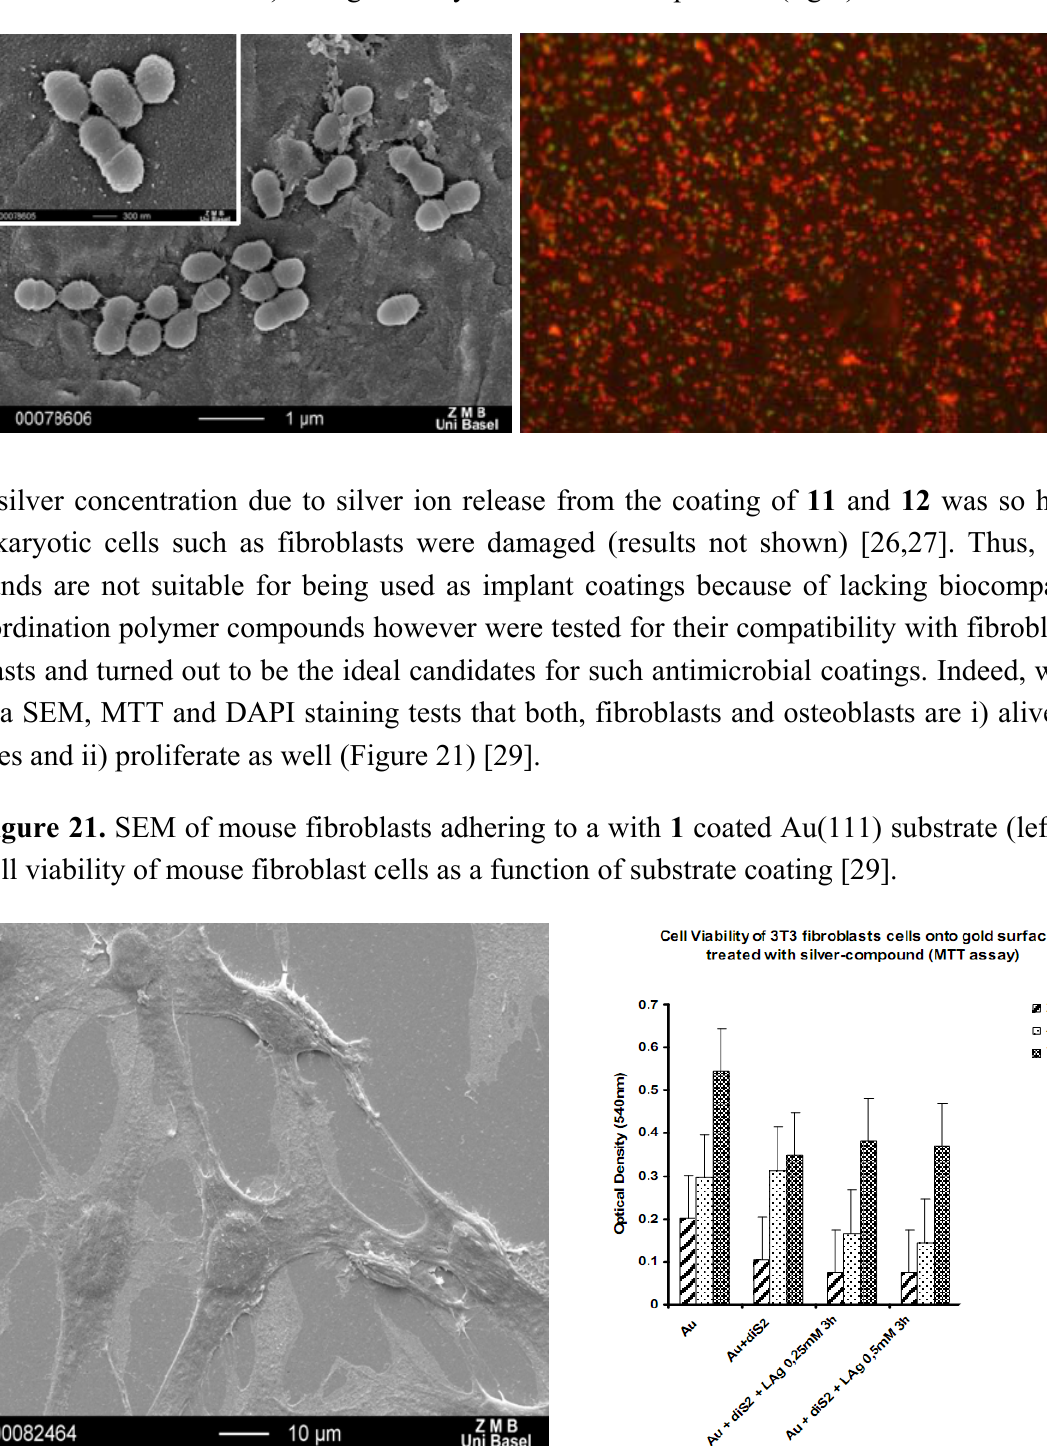
Figure 20. Bacterial adhesion to gold alloy (left) and optical micrograph of dead bacteria (with fluorescent marker) on a gold alloy coated with compound 1 (right).